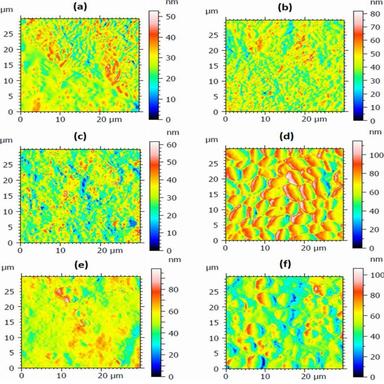
Relevant 3D AFM micrographs of samples: a) BF1, b) BF2, c) BF3, d) B4, e) BF5 and, f) BF6.